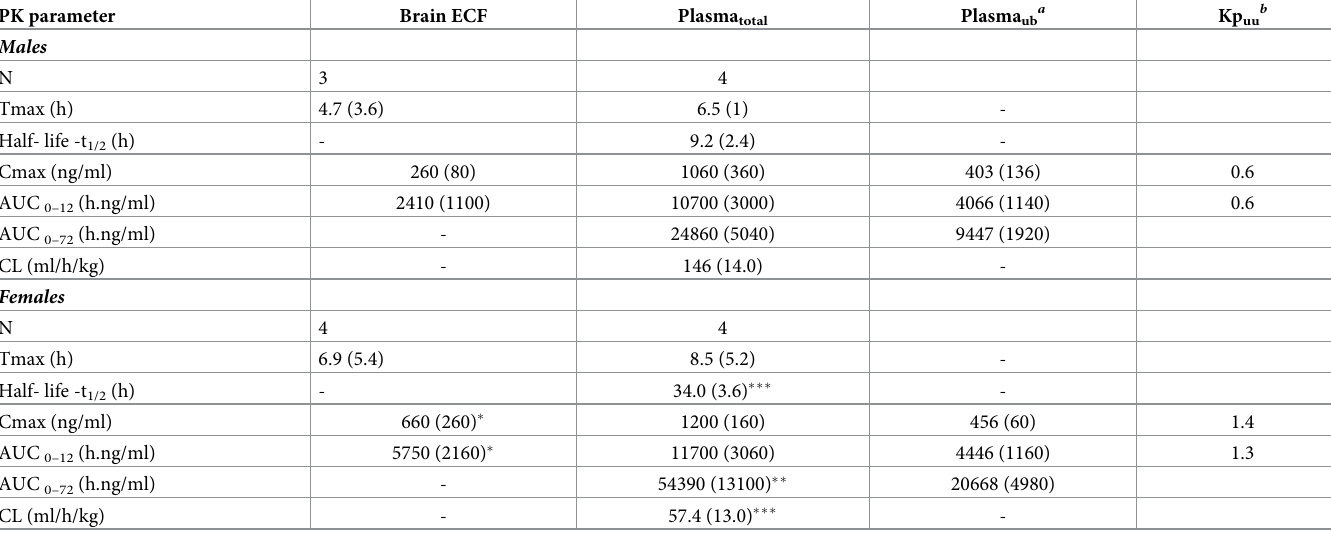
Table 2. Brain and plasma pharmacokinetics and unbound partition coefficients (Kp uu ) of letrozole after a single dose of 4 mg/kg in both male and female Sprague- Dawley